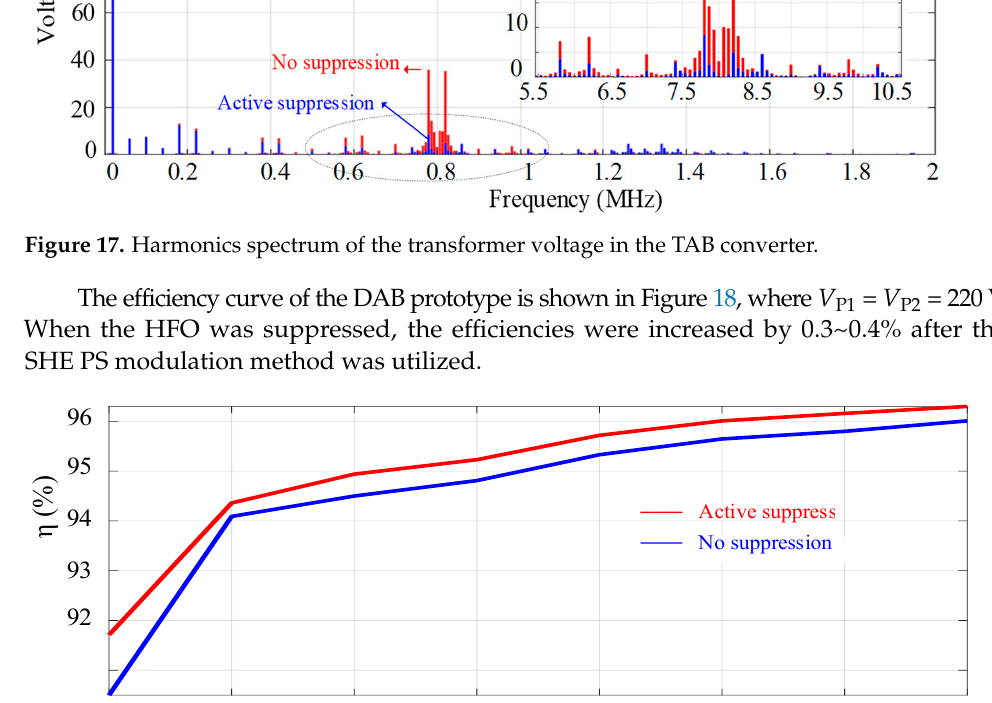
Figure 18. Efficiency curve of the DAB prototype.